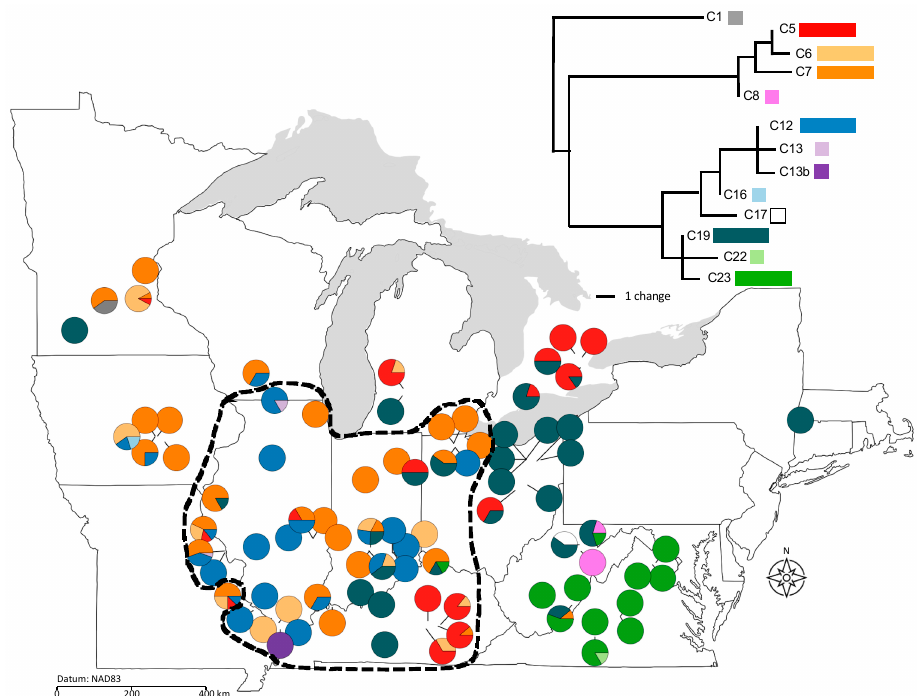
Figure 2. Distribution of 13 plastid haplogroups within and among populations of Lobelia siphilitica from 2009 and 2011. Colors correspond to haplogroups shown in the inset. Between 2 and 46 indi- viduals (mean = 7.01) were sampled in each population. The black dashed line indicates delineation between central and peripheral populations based on ecoregion. Inset shows the phylogram for the 13 pt haplogroups (see: Figure S2). Long bars indicate common haplogroups and short bars indicate rare haplogroups.